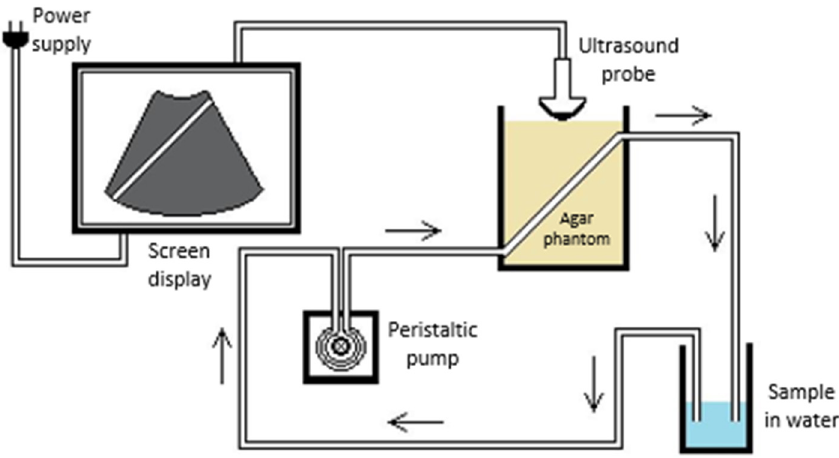
Figure 1. Experimental agar phantom model for US contrast evaluation of PFP loaded drug carrier.